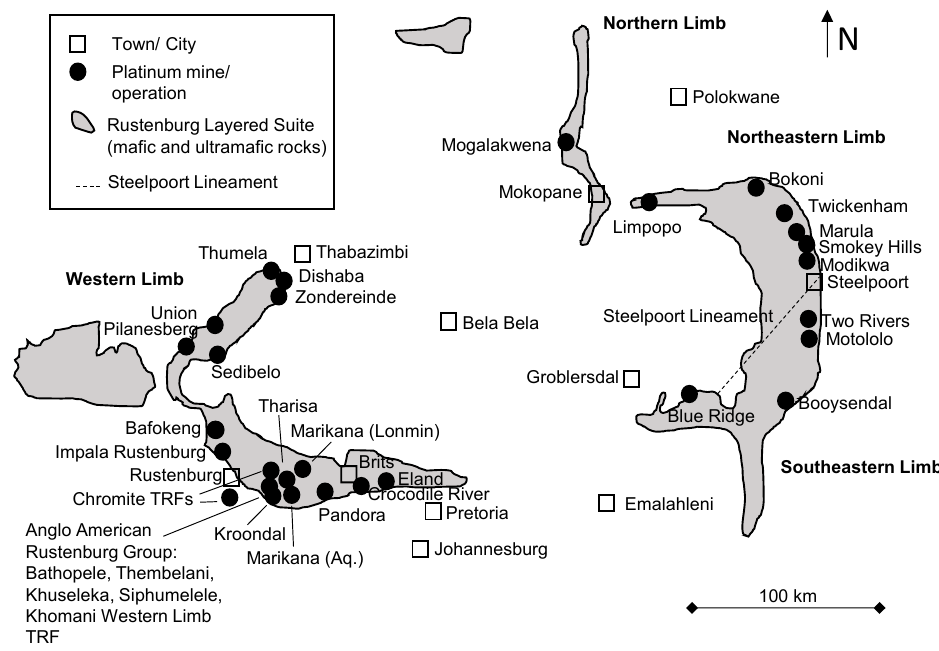
Figure 3. Mines and mine projects in the South African Bushveld Complex.